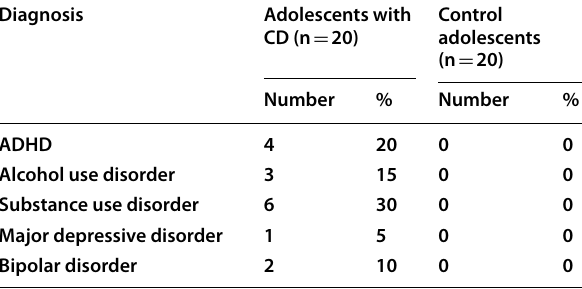
ADHD attention-deficit hyperactivity disorder